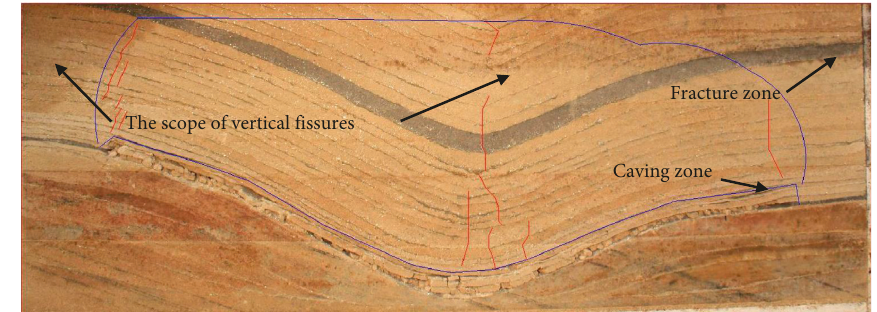
Figure 12: The scope of caving zone, fracture zone, and vertical